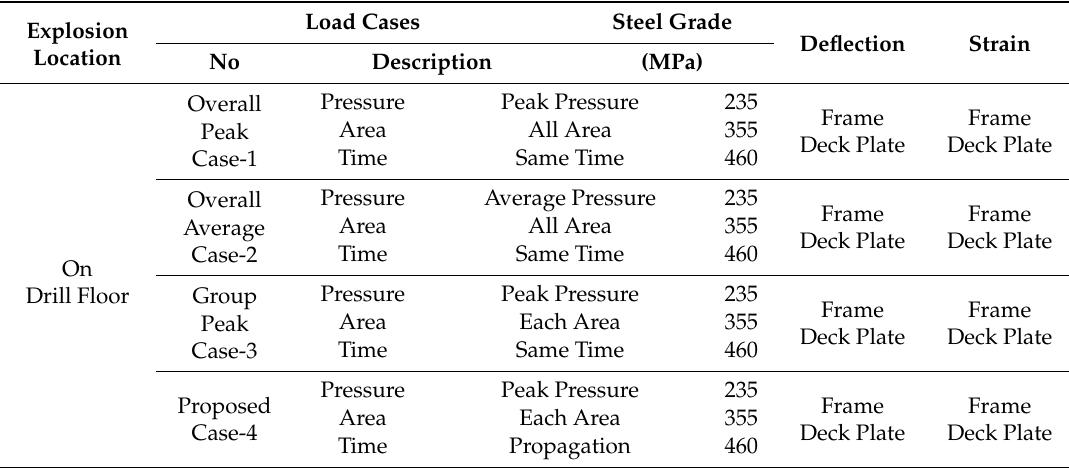
Table 7. Load cases for analysis of structure